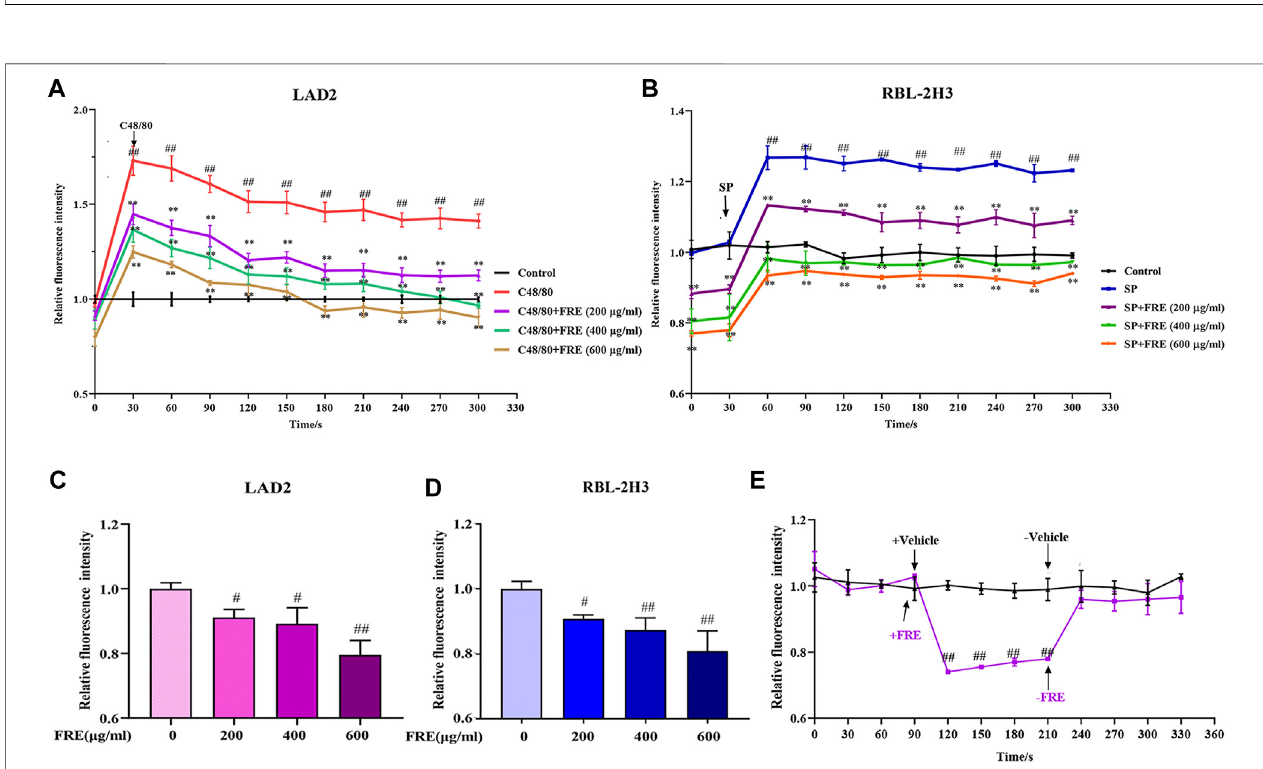
FIGURE 5 | FRE concentration-dependently reduces the Ca 2+ [c] level ( n (cid:2) 3 ). (A,B) FRE reduces C48/80-elicted Ca 2+ [c] rise in LAD2 cells (A) and IgE/Fc ε RI-mediated Ca 2+ increase in sensitized RBL-2H3 cells (B) .Cells wereloaded withFluo-3 AM (4 μ M) at 30 ° Cfor30 minand then treated withor withoutFRE for30 min and exposed toC48/80(10 μ g/ml)orSP(40 ng/ml).The fl uorescenceintensity( λ e x 485 nm/ λ em 538 nm)wasdetectedevery30 s. ## p < 0.01 vs. control,** p < 0.01 vs. SPorC48/80 alone. (C,D) FRE reduces Ca 2+ [c] level in the resting LAD2 (C) and RBL-2H3 cells (D) . # p < 0.05 and ## p < 0.01 vs . control. (E) FRE reduces the Ca 2+ [c] level in a rapid and reversible manner in RBL-2H3 cells. ## p < 0.01 vs. control.